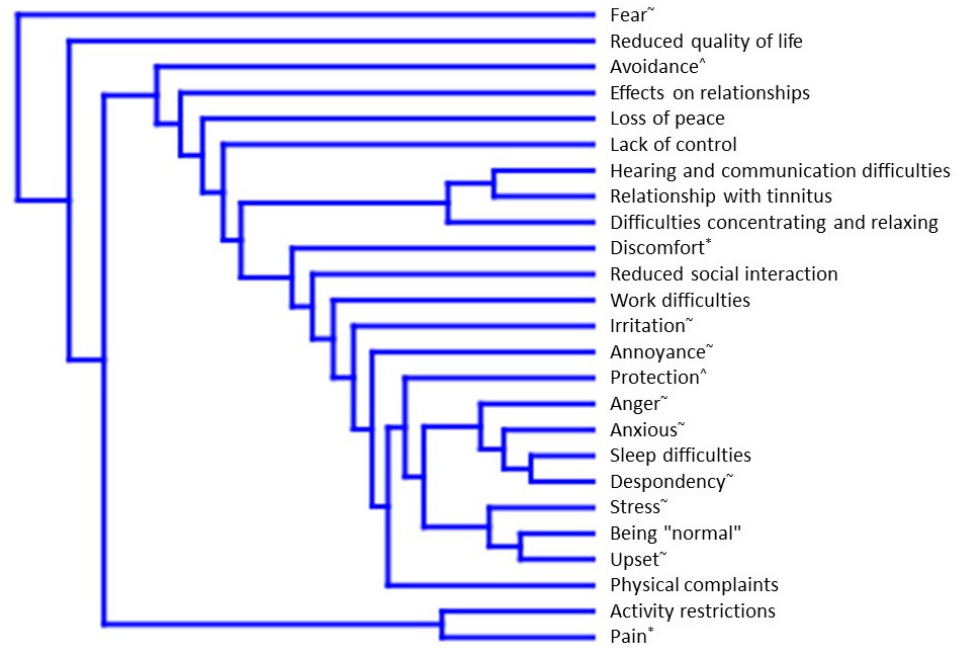
Figure 1. Cluster analysis indicating relatedness of hyperacusis problems within the responses from individual patients. * In overarching category: Experiencing physical reactions due to sound; ˆ In overarching category: Using safety behaviour; ~ In overarching category: Feeling emotionally unsettled due to the experience of